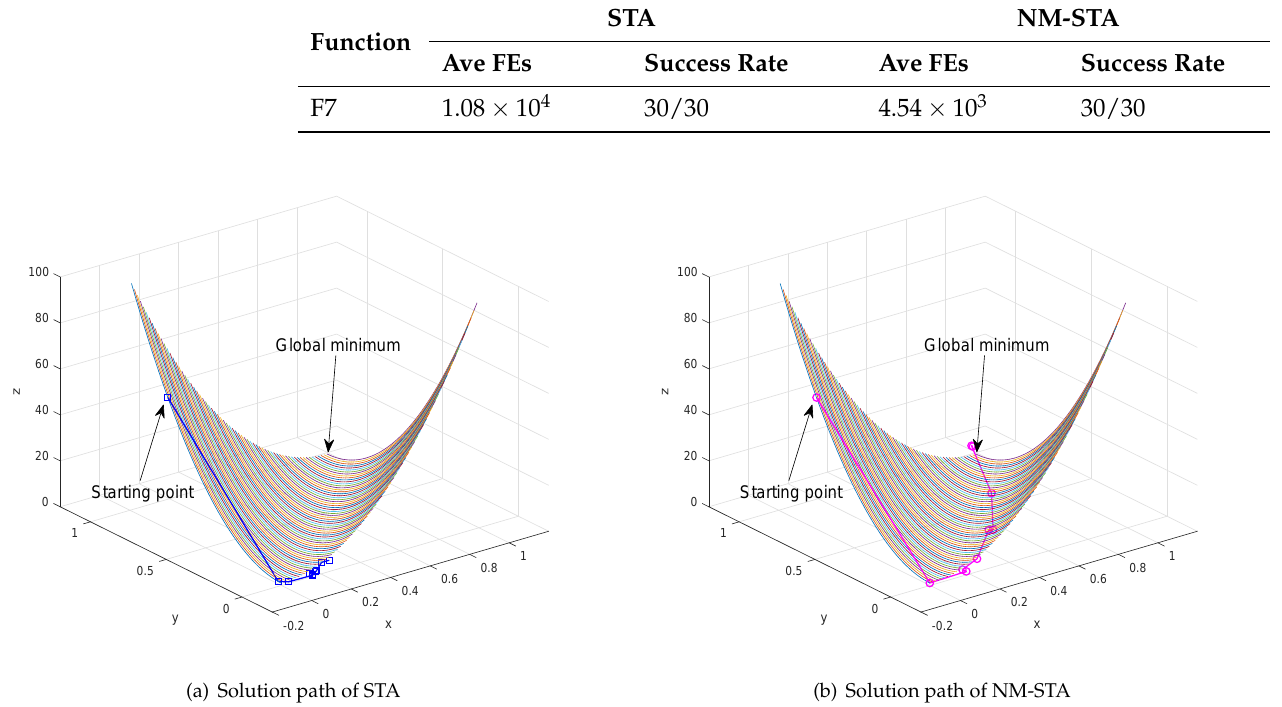
Figure 4. Solution paths of STA and NM-STA on a Rosenbrock